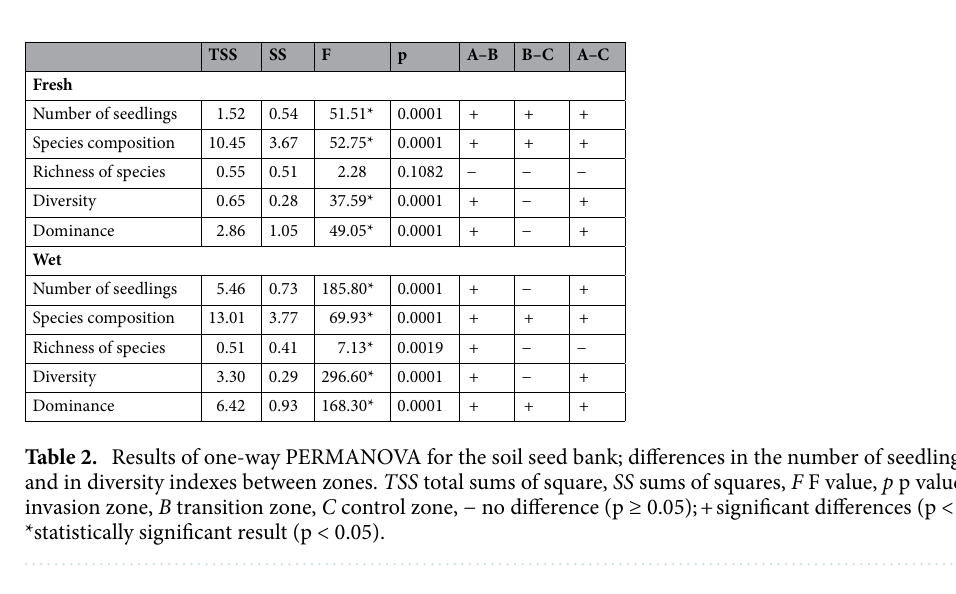
Table 1. The abundance of the soil seed bank and diversity indexes in three studied zones and two habitats (fresh and wet meadow). A invasion zone, B transition zone, C control zone, ∑ total number of seedlings, X mean number of seedlings in a sample (upper layer plus lower layer of soil); the abundance of the seed bank (seeds)/m 2 , Number of species total number of seedlings’ species detected in a given zone, species richness mean number of seedling species in a sample, Diversity mean Shannon–Wiener index in a sample, Dominance mean index of value 1 minus Simpson index in a sample.